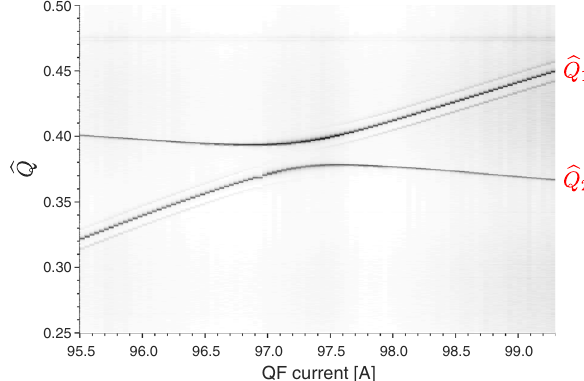
FIG. 11. FFTof beam motion at the top of the ramp for different currents of the QF family. The horizontal fractional normal mode tune changes from 0.325 to 0.450 when changing the QF current ¼ 95 . 5 A to 99.3 A. The smallest tune separation is from I QF ¼ 97 . 25 A revealing a coupling coefficient reached around I QF amplitude of j C j ¼ 0 . 019